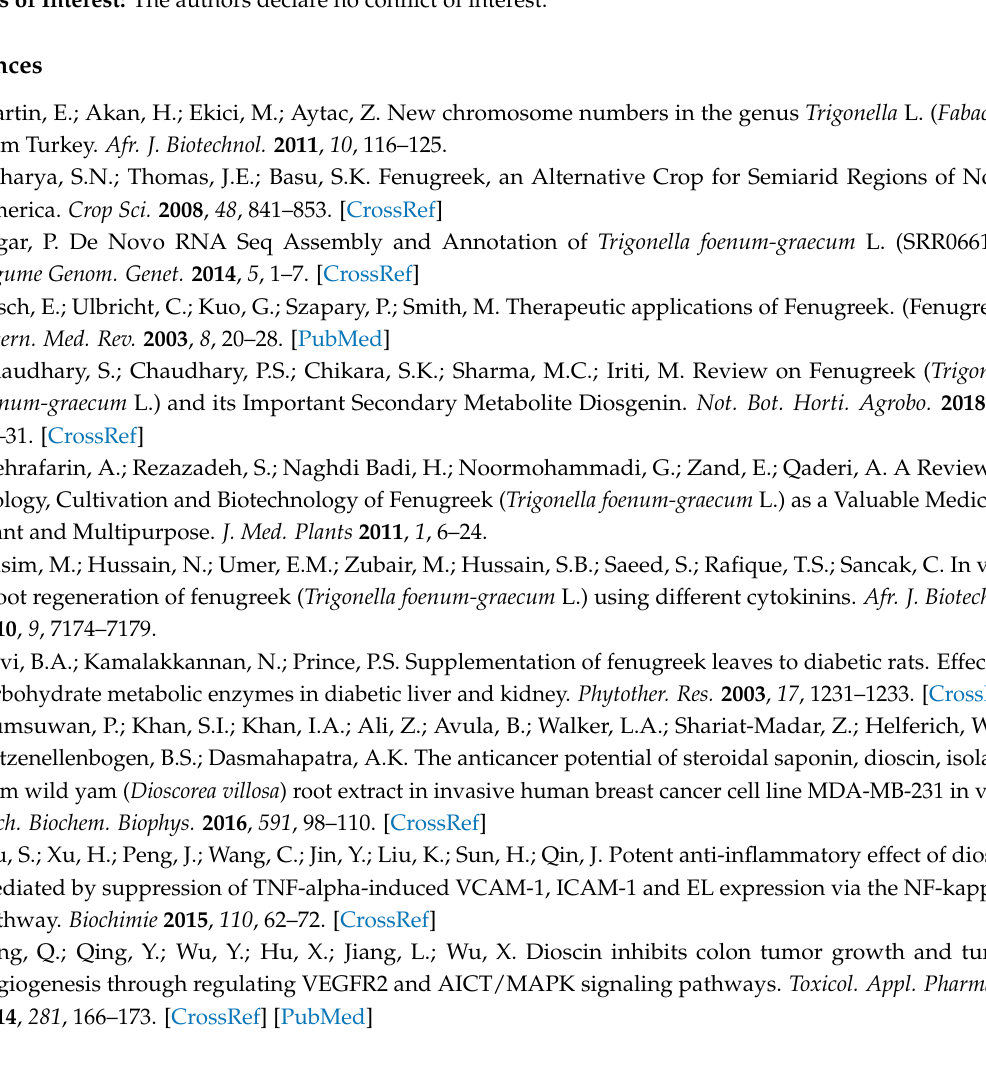
Supplementary Materials: The following are available online. Table S1: Transcript abundance (FPKM values) of the backbone unigenes for cholesterol biosynthesis under all the MeJA-treated time points. The expression levels of the candidate genes in the 24 h-MeJA and the 24 h-control lines were highlighted by red colors. Table S2: Transcript abundance (FPKM values) of the potential CYP candidates under all the MeJA-treated time points. The expression levels of the CYP candidate genes in the 24 h-MeJA and the 24 h-control lines were highlighted by red colors. Table S3: Transcript abundance (FPKM values) of the UGT candidates under all the MeJA-treated time points. The expression levels of the UGT candidate genes in the 24 h-MeJA and the 24 h-control lines were highlighted by red colors. Table S4: Transcript abundance (FPKM values) of the β -glucosidase candidates under all the MeJA-treated time points. The expression levels of the β -glucosidase candidate genes in the 24 h-MeJA and the 24 h-control lines were highlighted by red colors. Table S5: Transcript abundance (FPKM values) of the transcription factor (TF) candidates under all the MeJA-treated time points. The expression levels of the TF candidate genes in the 24 h-MeJA and the 24 h-control lines were highlighted by red colors. Table S6: Primers for amplifying transcripts in the qRT-PCR experiment. Figure S1: GO enrichment analysis for the MeJA-induced differentially expressed genes in the category of “biological process” Figure S2: GO enrichment analysis for the MeJA-induced differentially expressed genes in the category of “cellular component” Figure S3: GO enrichment analysis for the MeJA-induced differentially expressed genes in the category of “molecular function”. Figure S4: Phylogenetic